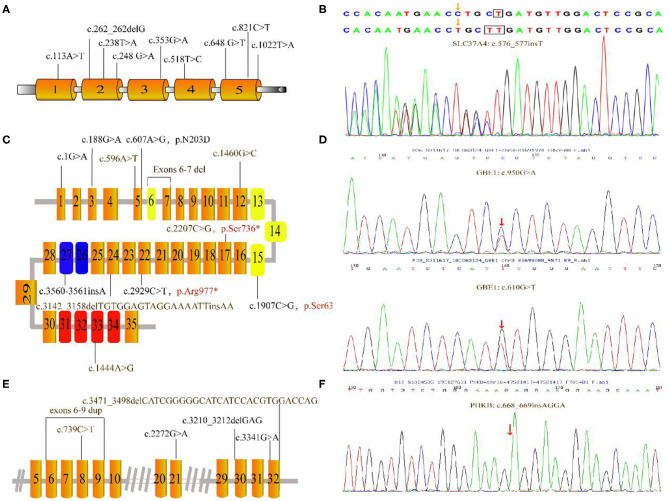
Mutations depicted in this research. (A) Schematic diagram of the G6PC gene showed the locations of the mutations. (B) The c.576_577insT mutation in SLC37A identified by GSD-NGS panel(red arrow). (C) Organization of the AGL gene and mutations associated this study; the three main functional domains including transferase catalytic residues (yellow boxes), amylo-1, 6-glucosidase catalytic site (blue boxes) and glycogen-binding domain (red boxes). (D) Partial genomic sequences of the GBE1 gene with heterozygous missense mutations (red arrow). (E) Partial schematic representation of the PHKA2 gene. (F) Electropherogram of PHKB cDNA of our patient. The number in each box represent exons. Unreported mutations are denoted in brown, and reported mutations are in black. Mutation marked in red stands for nonsense mutation. Gray lines indicate introns (not to scale).